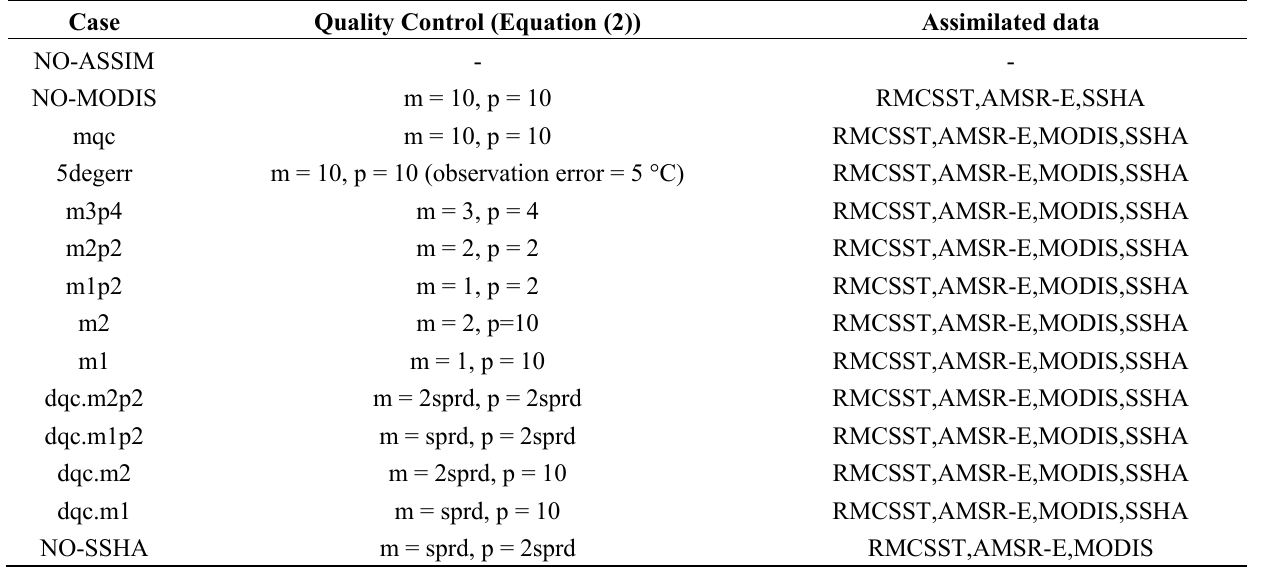
Table 2. Description of model